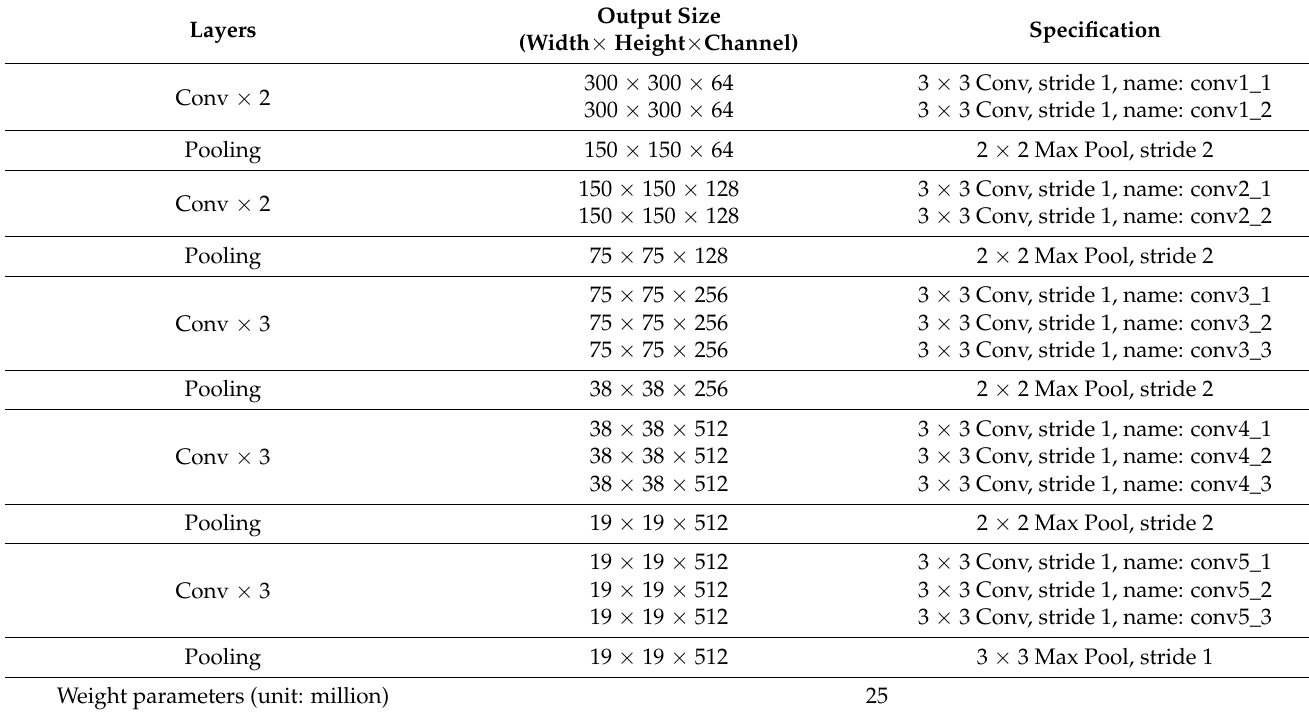
Table 3. Model specification of VGGNet based on SSD architecture.